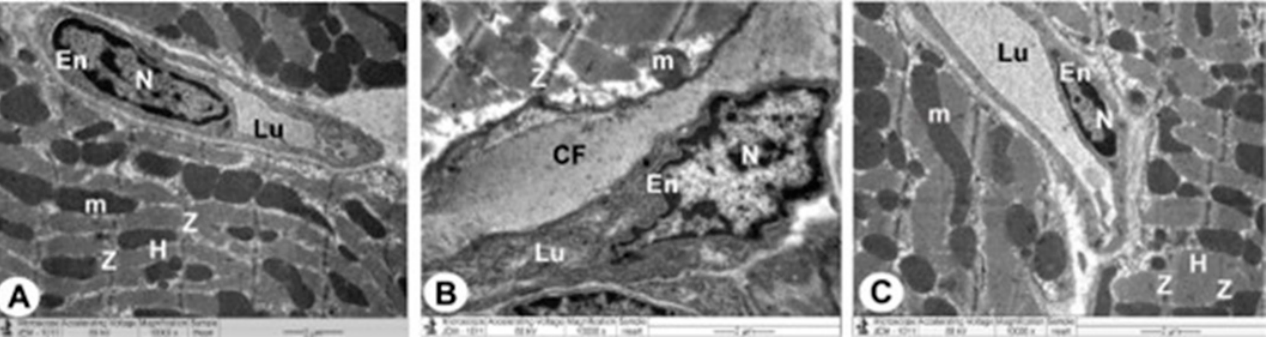
Figure 5. TEM micrographs of the mitochondria, Z and H band and endothelial cells from all groups. The control group ( A ) shows a normal myocardial striation architecture with well-preserved mitochondrial (m) integrity. Healthy myofibrils with a striated pattern and distinct bands (Z and H) are found in a packed cytoplasm, and capillaries are composed of simple squamous endothelial cells (En) with their nucleus (N). The endothelial cells are connected by overlapping to form a vascular lumen (Lu). The endotoxin group ( B ) displays enlarged mitochondria (m), more distorted capillaries with deformed endothelial cells (En) and disturbed myofibrils with disarrangement of muscle bands (Z and H) that form vascular lumen (Lu) with its disrupted irregular nucleus (N). Note that deposition of collagen fibrils (CF) is seen. Endotoxin plus Vit C group ( C ) reveals typical architecture with well-preserved integrity and a striated pattern of clear bands (Z and H), preserved mitochondria (m), intact capillaries with normal endothelial cells (En) that form vascular lumen (Lu) and a healthy nucleus (N).